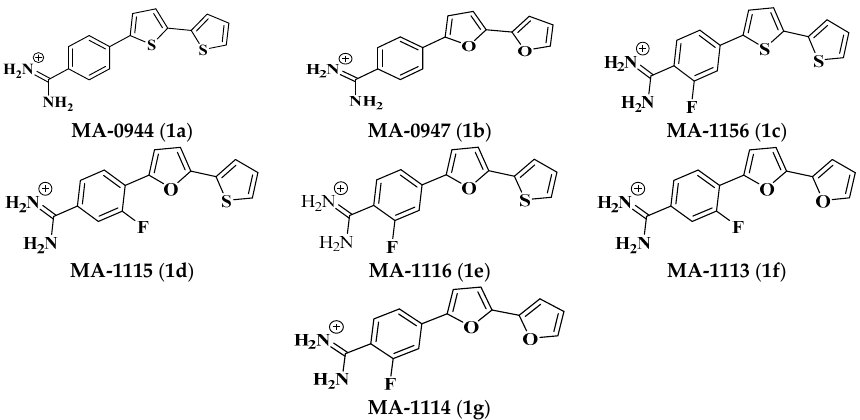
Figure 1. Chemical structures of monocationic bichalcophene derivatives. Table 1. Inhibitory effect of monocationic bichalcophenes on S. aureus .